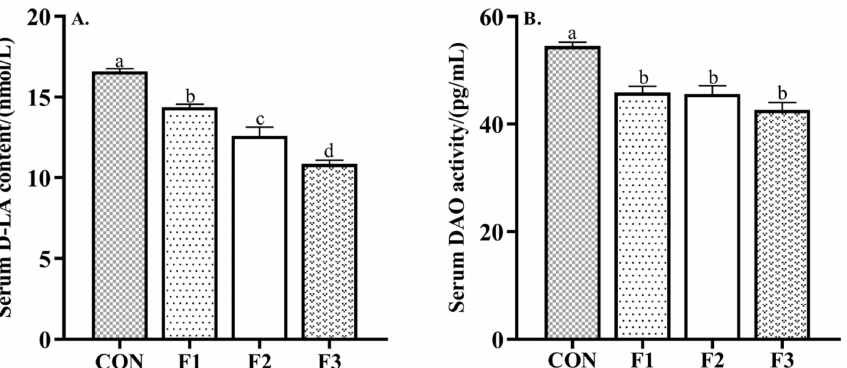
Figure 1. Effects of dietary fucoidan supplementation for 30 days on intestinal permeability in weaned goat kids. ( A ) Serum D-LA content; ( B ) serum DAO activity. Results are presented as mean ± SEM. a–d means significantly different ( p < 0.05). CON, basal diet; F1, basal diet + 0.1% fucoidan; F2, basal diet + 0.3% fucoidan; F3, basal diet + 0.5% fucoidan. D-LA, D-lactic acid; DAO, diamine oxidase.